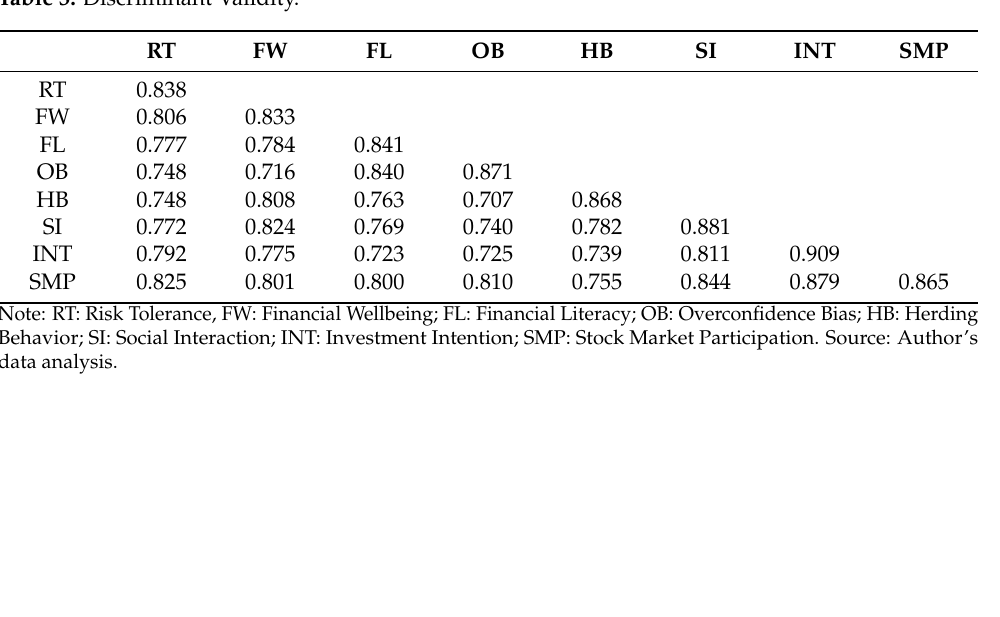
Table 3. Discriminant